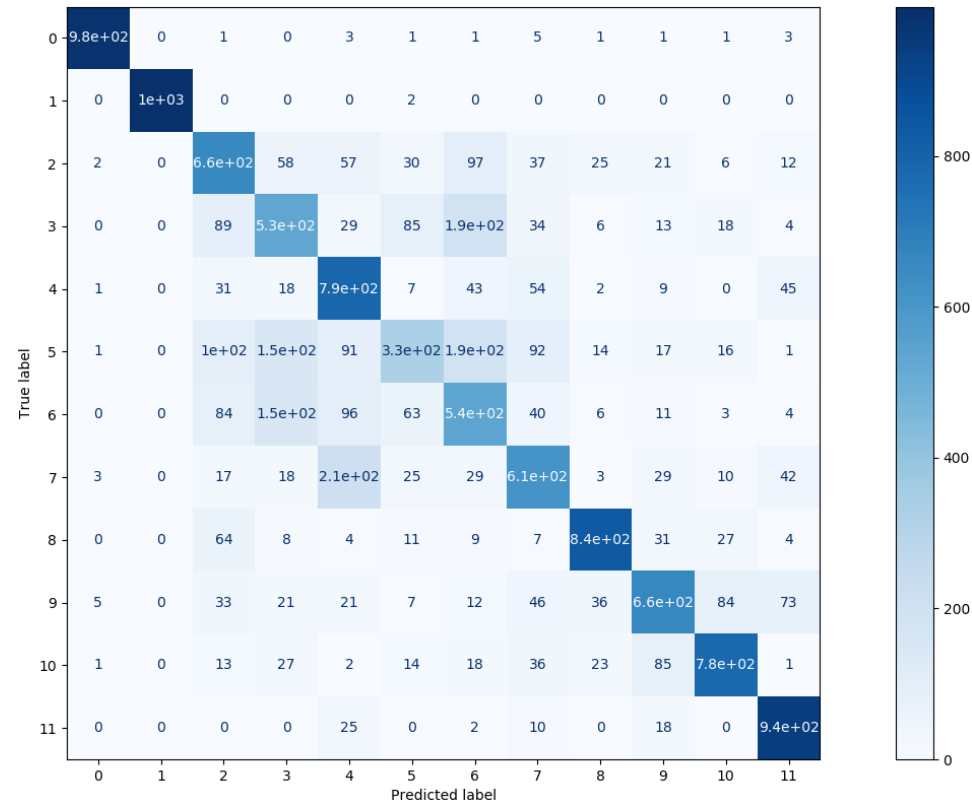
Figure 13. Confusion matrix of the conventional two-layer LSTM trained on mic.